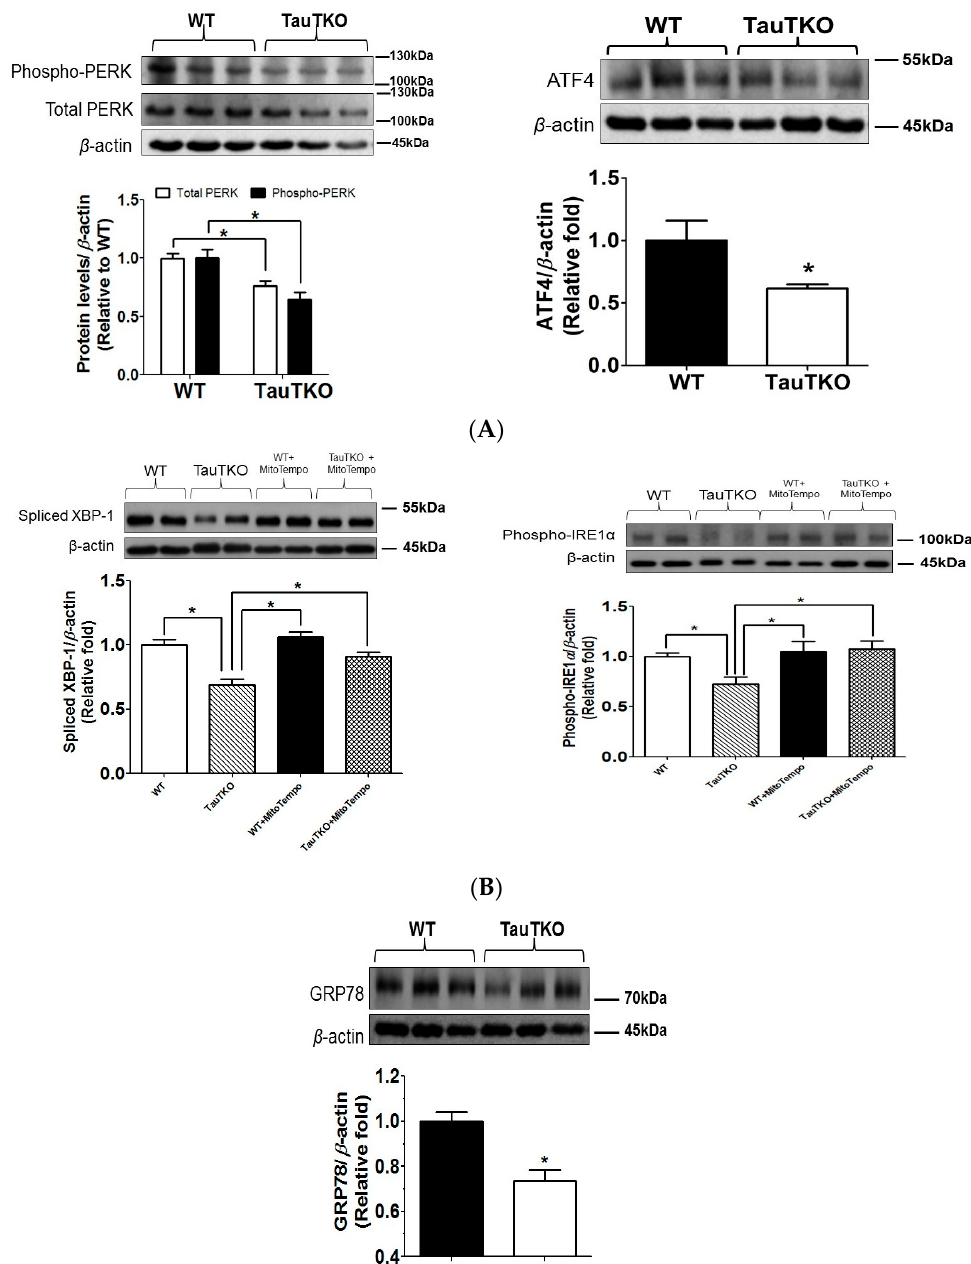
Figure 6. Unfolded protein response (UPR) is not activated in TauTKO hearts at an early age. Total lysates from 3-month-old WT and TauTKO mice treated with or without MitoTempo were subjected to western blot analysis of ( A ) phosphorylated PERK and ATF4 ( B ) spliced XBP-1 and phosphorylated-IRE1 and spliced XBP-1 and ( C ) GRP78. Each panel contains a representative gel and summation data expressed as means ± SEM of 6–9 hearts. Values are expressed relative to WT, where WT is fixed at 1.0. * p < 0.05.